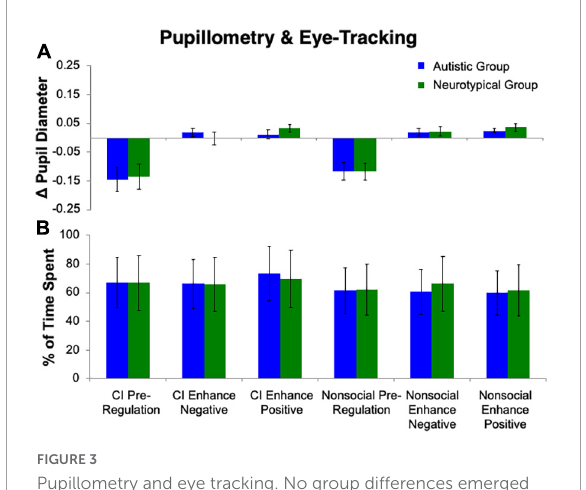
FIGURE3 Pupillometry and eye tracking. No group differences emerged for (A) change in pupil diameter or (B) percentage of time spent on